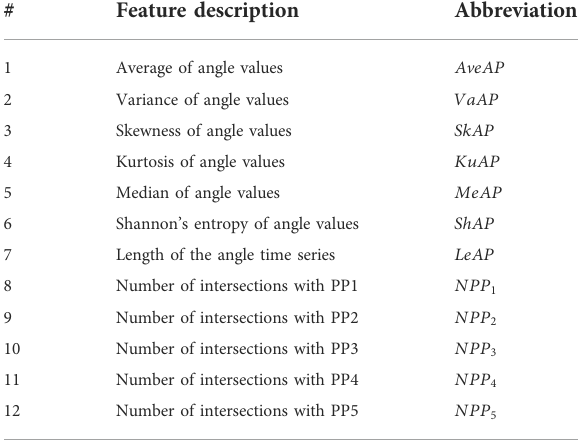
TABLE 2 Extracted features from AP and PPs for source identi fi